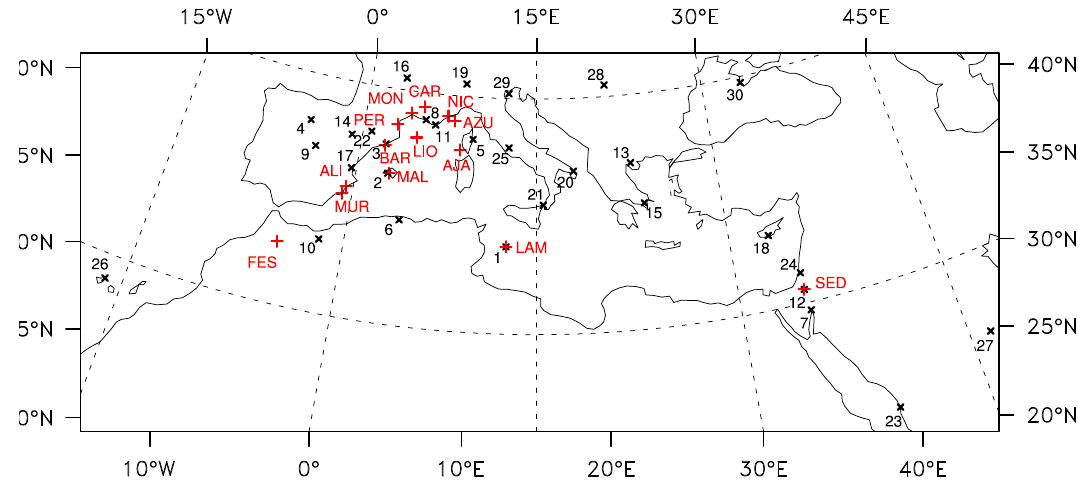
Figure 1. Stations of the AERONET network (black crosses, see the list of the corresponding numbers in Fig. 4). Red crosses indicate the stations providing measurements of surface radiation and temperature (see the list in Table 1). sidered in this model.